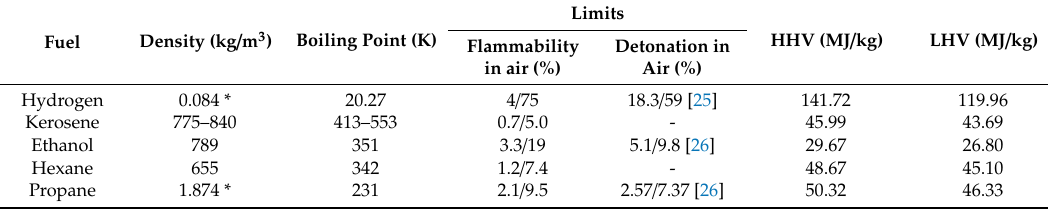
Table 3. Properties of fuels (based on: [23,24]).